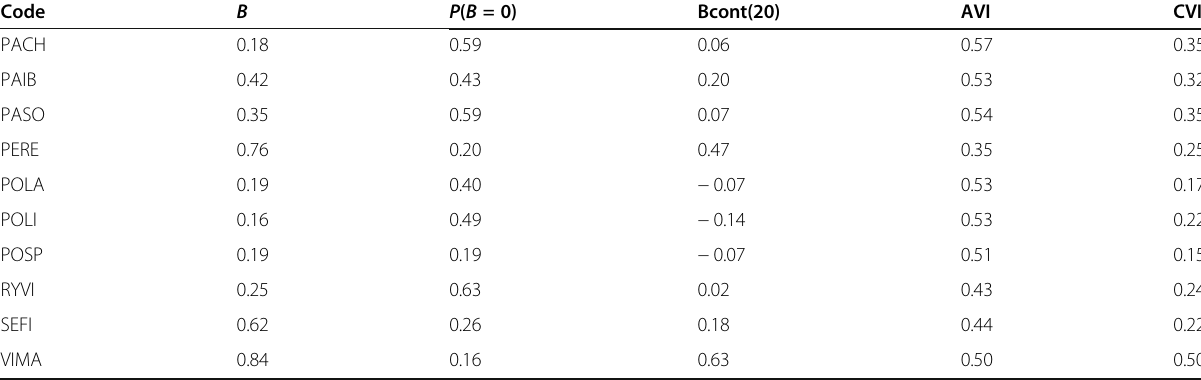
Table 7 Cross-validation values for each potential habitat suitability model of plant species of Santa Cruz Province (Continued)